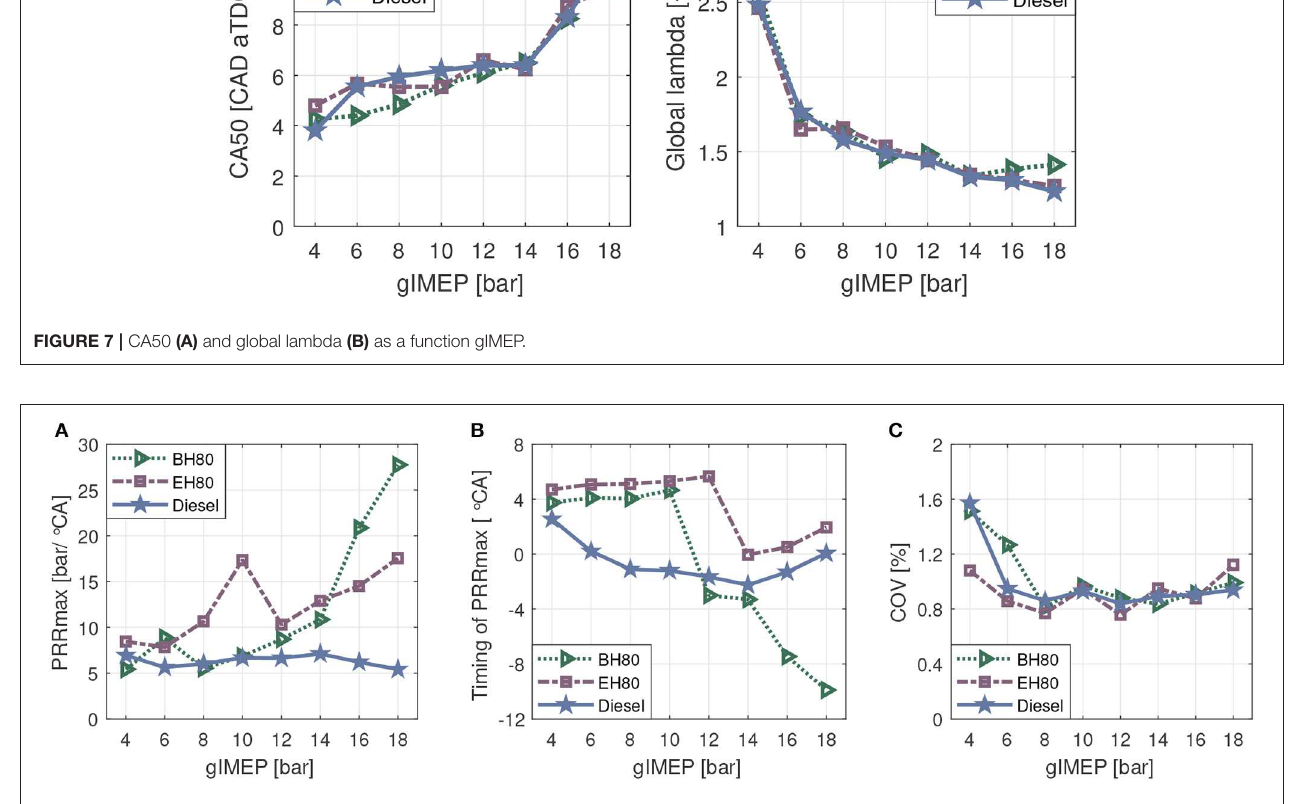
FIGURE 8 | PRRmax (A) , Timing of PRPmax (B) , and COV gIMEP (C) as a function of gIMEP.